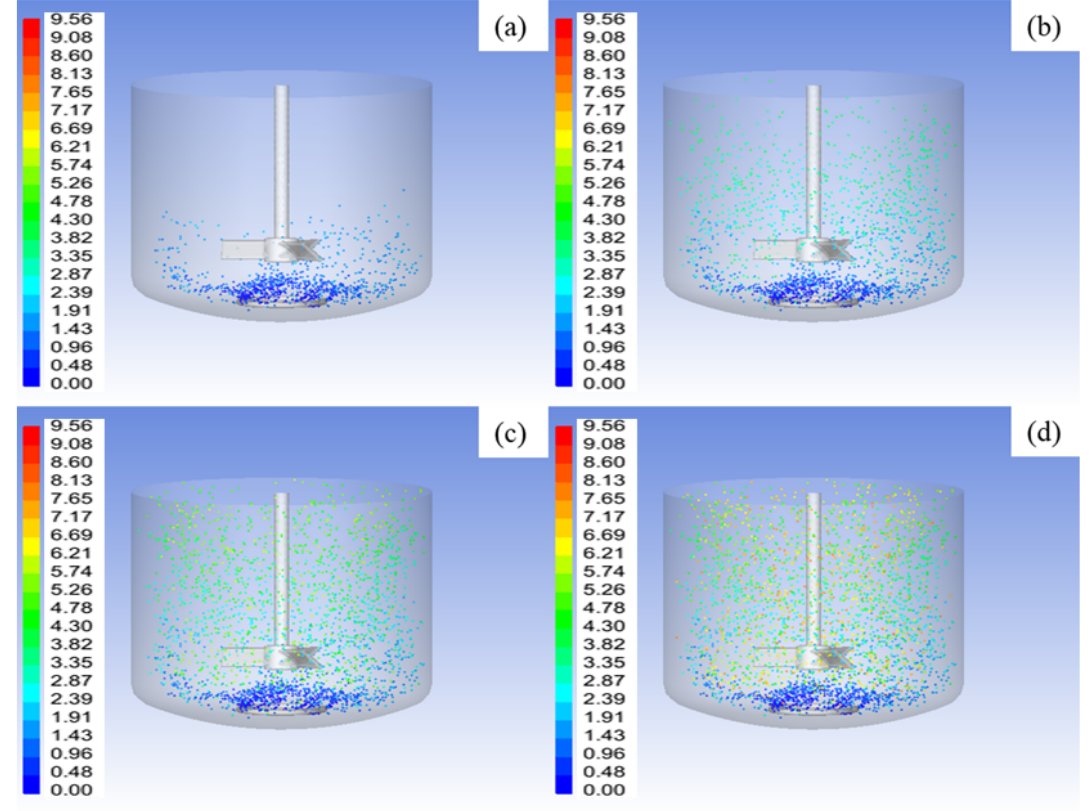
Figure 12. The bubble particle distribution in the autoclave. ( a ) t = 2 s; ( b ) t = 4 s; ( c ) t = 6 s; ( d ) t = 8s. The particles are captured on the pressure outlet boundary of the autoclave, and the residence time distribution of the bubble particles can be quantitatively calculated using statistical particle information (Figure 13). We counted the residence time of some particles. The residence time distribution of the bubble particles shows a tailing phenomenon, and the peak value of the residence time appears at t = 5 s.